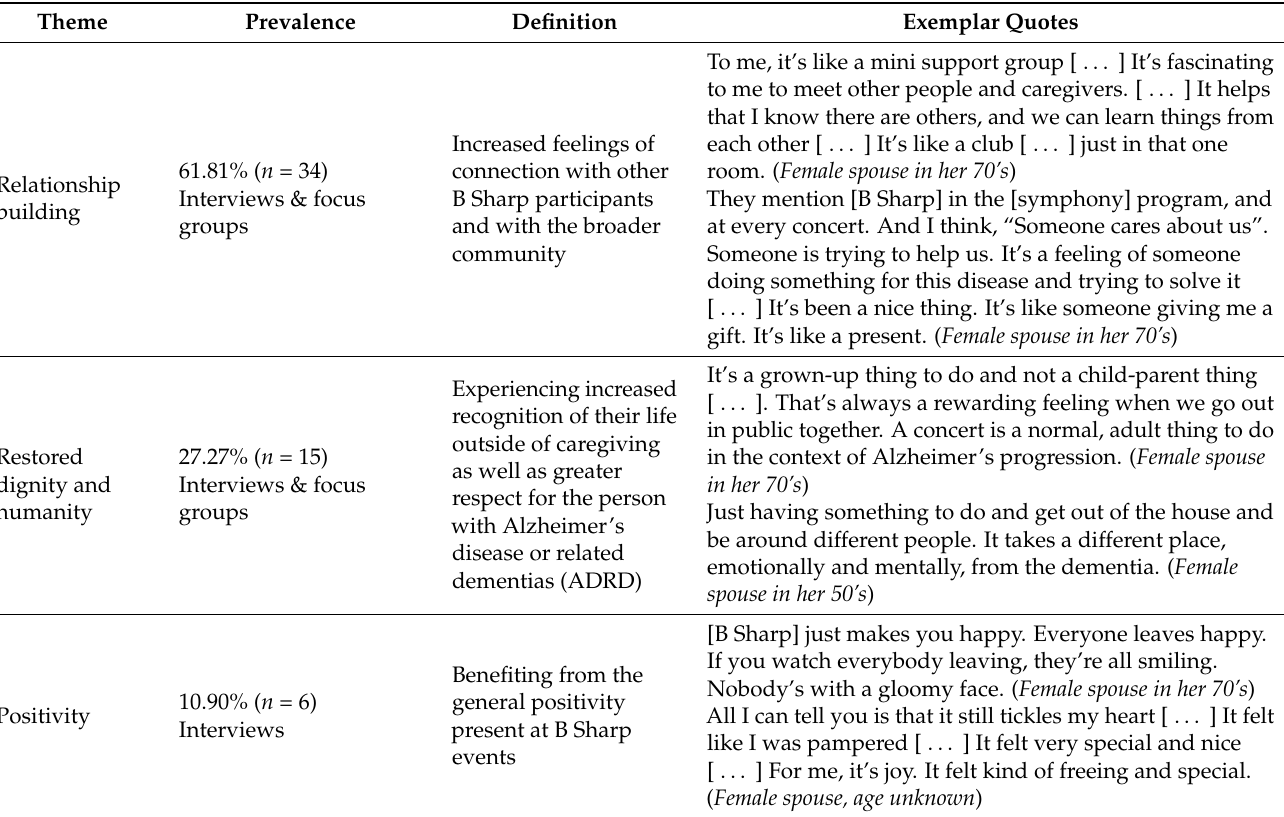
Table 2. Summary of Thematic